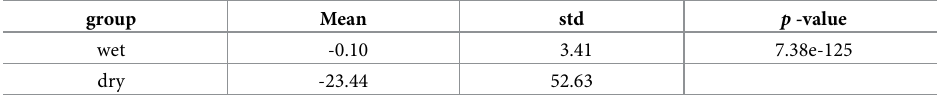
Fig 7. Applied Fourier Transform on RER in temporal domain. ( a ) RER in time domain ( b ) RER in frequency domain. https://doi.org/10.1371/journal.pone.0234592.g007 Table 1. The results after applying two-sampled t -test to the two groups of